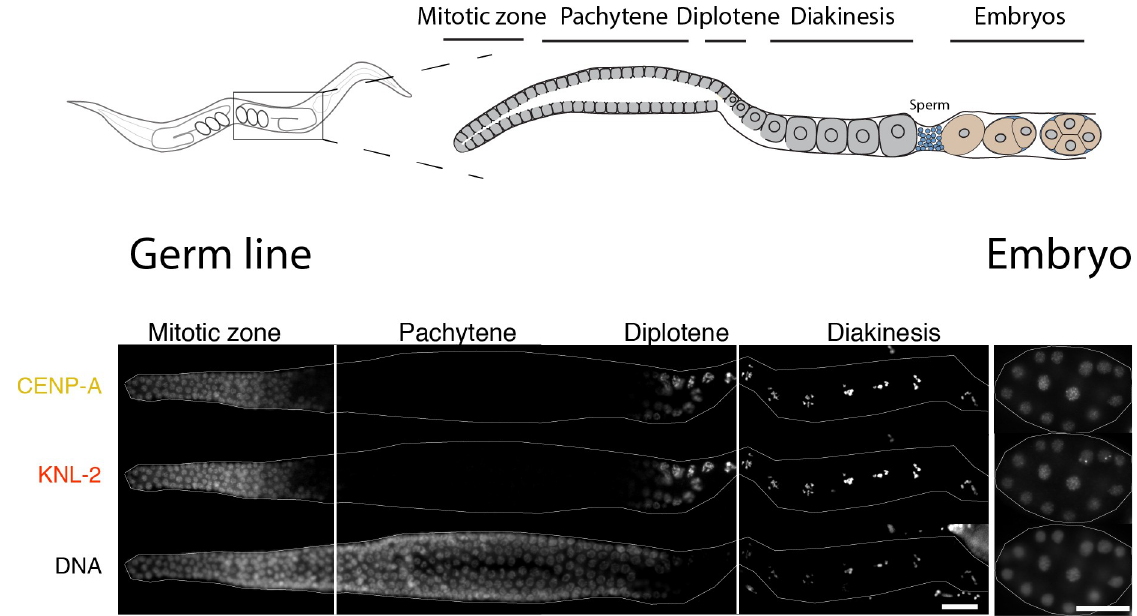
Fig 1. Dynamics of KNL-2 and CENP-A in the C . elegans germ line. Top, cartoon images of an adult hermaphrodite C . elegans and the different stages of the germ line. Bottom, IF images of CENP-A and KNL-2 in adult hermaphrodite germ lines and embryos, showing the removal at the mitosis-to-meiosis transition and the reappearance at the diplotene stage. The white lines indicate where images of the same gonad have been merged. Scale bars represent 20 μ m. CENP-A, centromere protein A; IF, immunofluorescence.